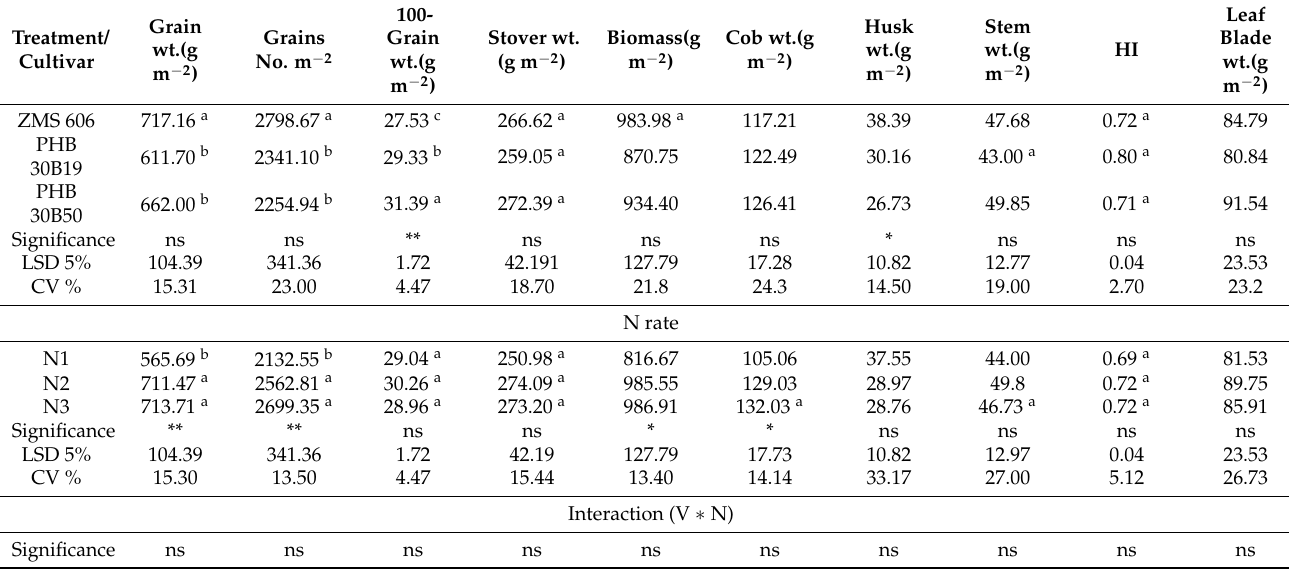
Table 5. Treatment effect of the cultivar and N on the grain wt., grain number m − 2 , 100-grain wt., stover wt., aboveground biomass wt., grain No. m − 2 , cob wt., ear wt., husk wt., stem wt. and leaf blade wt. under irrigated conditions. Grain Treatment/ Cultivar